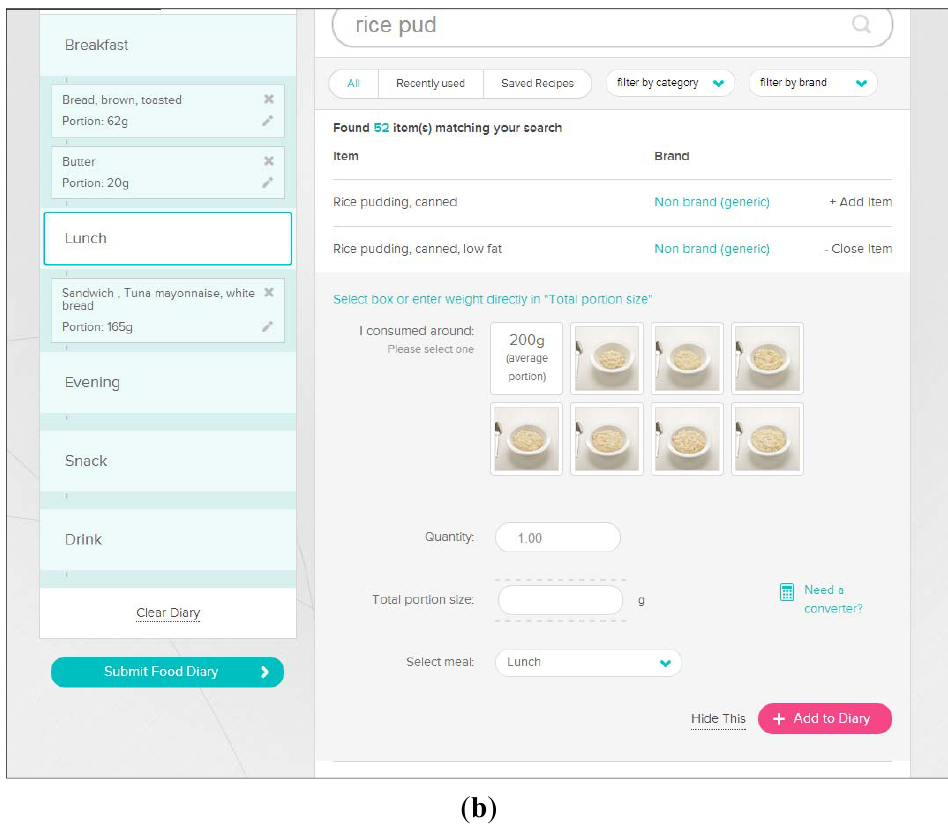
Figure 4. ( a ) Screenshot to show searching and logging items consumed using myfood24. ( b ) Screenshot to show estimating portion sizes using